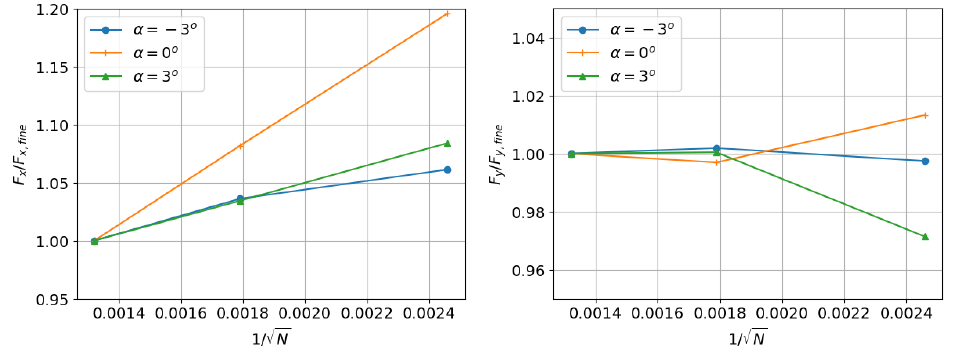
Figure 6. Mesh dependency of relative forces acting on the middle blade for α = − 3°, 0° and 3°, N is the number of mesh elements.